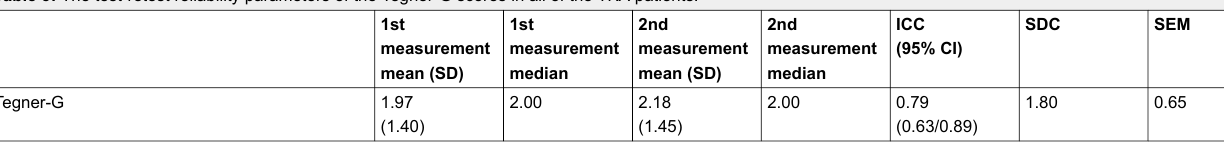
Table 3: The test-retest reliability parameters of the Tegner-G scores in all of the TKA patients.